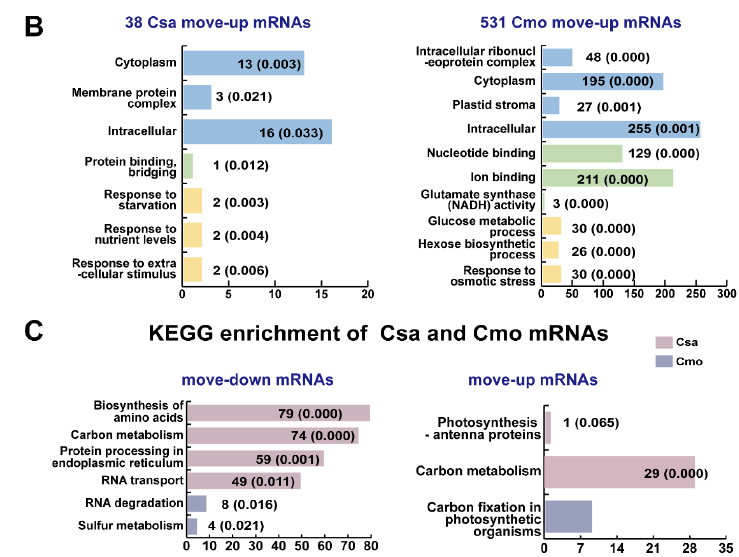
Figure 6. GO enrichment and KEGG pathway annotation of overlapping mobile mRNAs in upward and downward directions. ( A , B ) GO enrichment and ( C ). KEGG pathway analysis of upward and downward mobile mRNAs in all directions. Colored graphs indicate the classifications of molecular function, cellular component and biological process. Graphs were generated by EXCEL (Office 2010). The numbers beside each graph represent the number of genes in the cluster and the p value. Csa, Cucumis sativus; Cmo, Cucurbita moschata